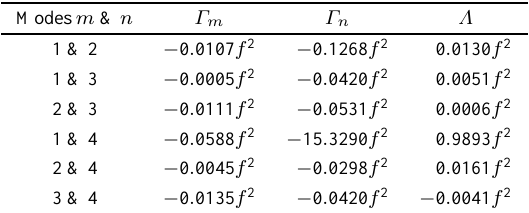
Values of the coefficients (cid:0) m , (cid:0) n , and (cid:3) for different combina- tions of the first four